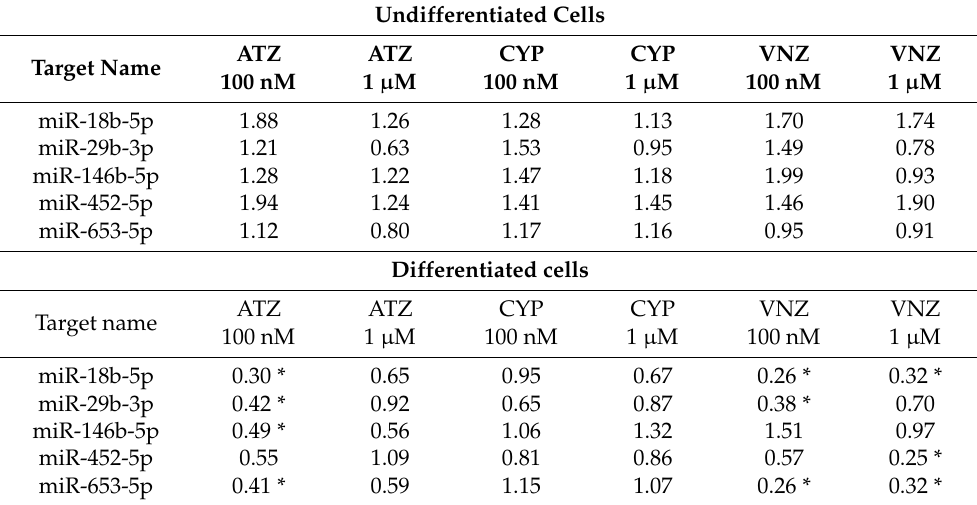
Table 1. qRT-PCR validation of miRNA expression in undifferentiated and differentiated SH-SY5Y cells. Quantitative analysis was performed by the 2 − ∆∆ Ct method and vehicle samples were consid- ered as the calibrator of the